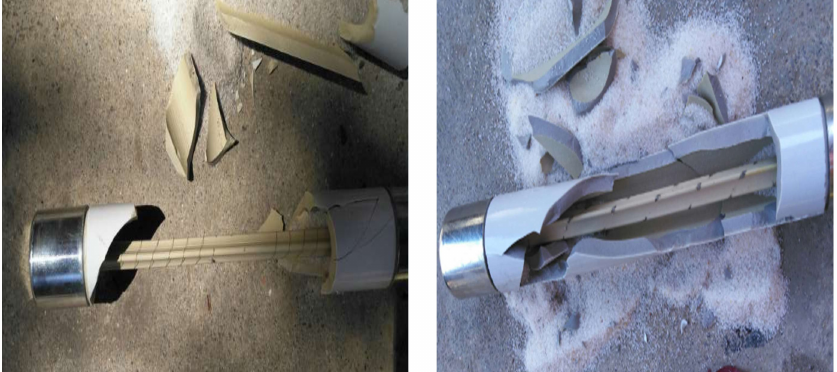
Figure 13. Blowing characteristic of